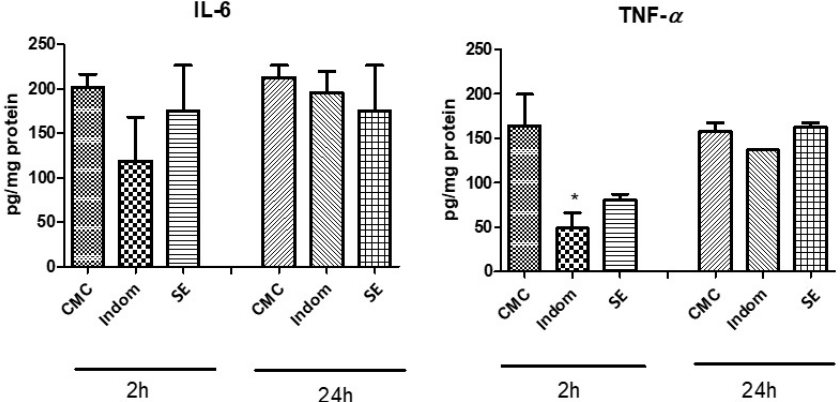
Figure 2. Levels of IL-6 and TNF- α in paw tissue of experimental rats at 2 h and 24 h after injection of carrageenan. Values are means ± SD. Statistical analysis was performed by a one-way ANOVA, with Tukey’s multiple comparisons post-test (* p < 0.05 vs. control, CMC, group).